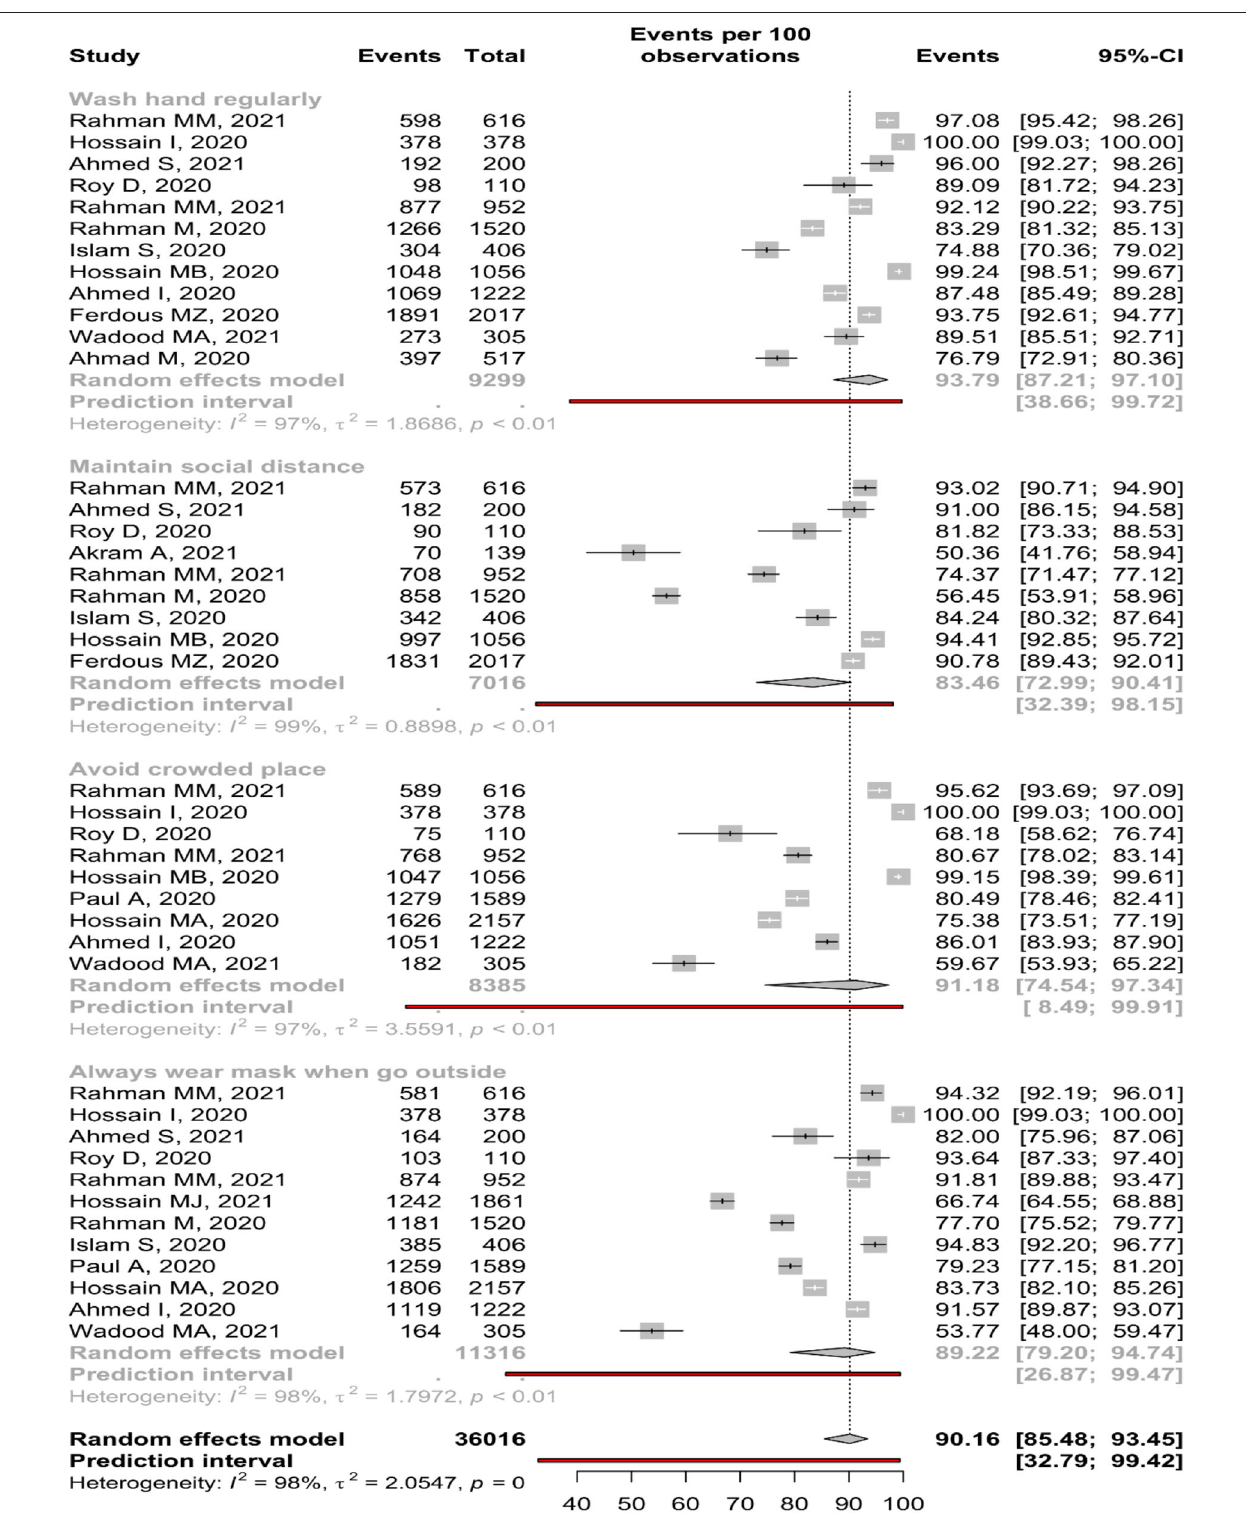
FIGURE 6 | Practice about COVID-19 among Bangladeshi residents.